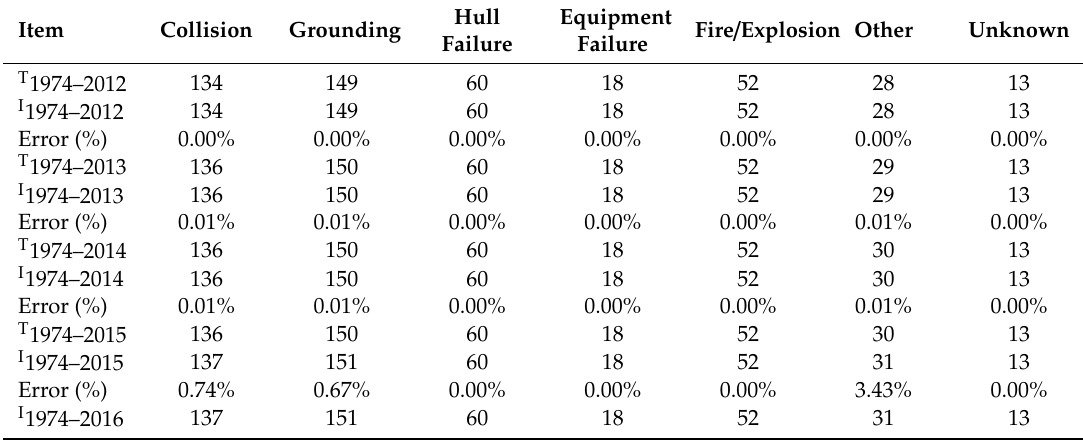
Table 11. Analysis of results of oil spills over 700 tons from 1974 to